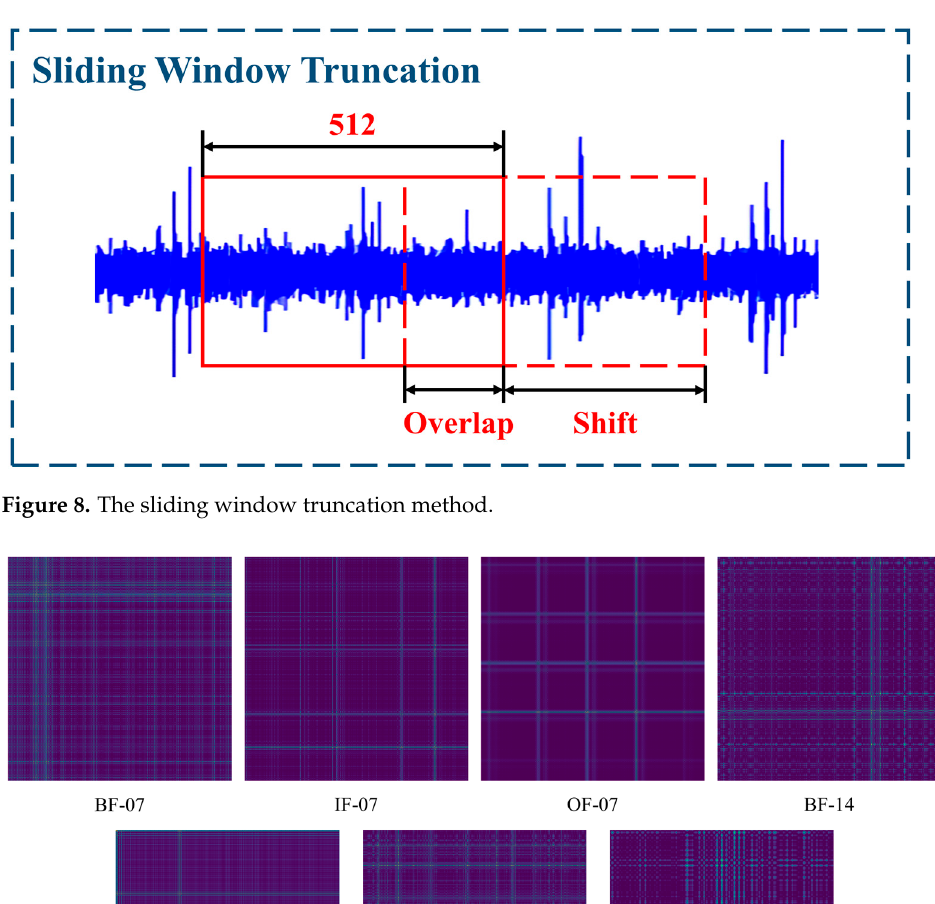
Figure 7. The CWRU bearing test rig.